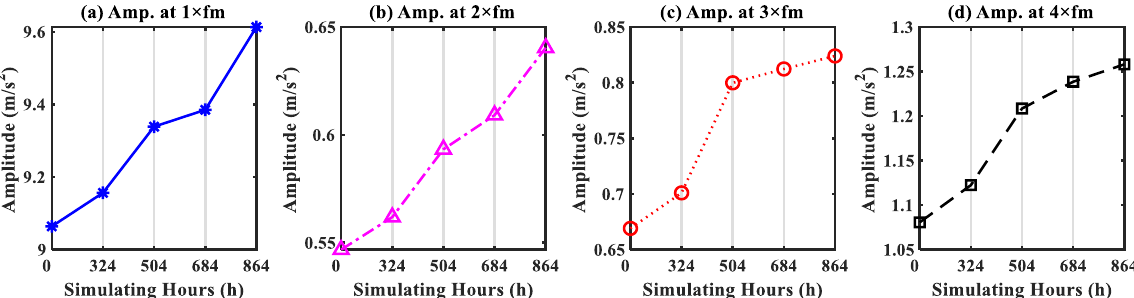
Figure 14. Amplitudes of the first four harmonics of the gear meshing frequency of simulated vibration. ( a ) Amplitudes of the first harmonic; ( b ) Amplitudes of the second harmonic; ( c ) Amplitudes of the third harmonic; ( d ) Amplitudes of the fourth harmonic.